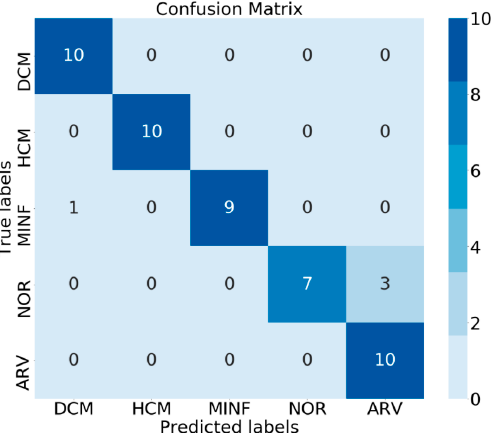
Figure 6. Confusion matrix of ensemble few-shot model on test leaderboard.